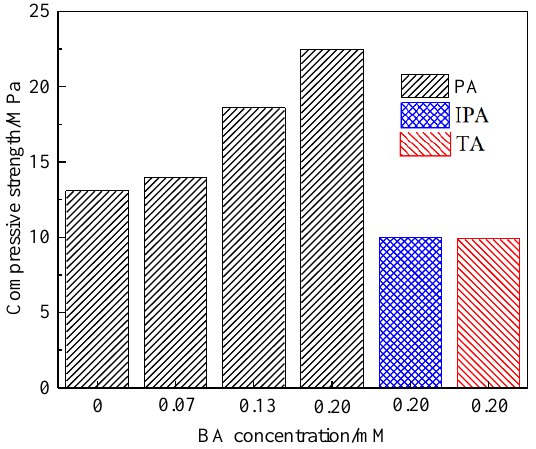
Figure 4. Effect of BA concentration on the compressive strength of CaSO 4 ·0.5H 2 O.